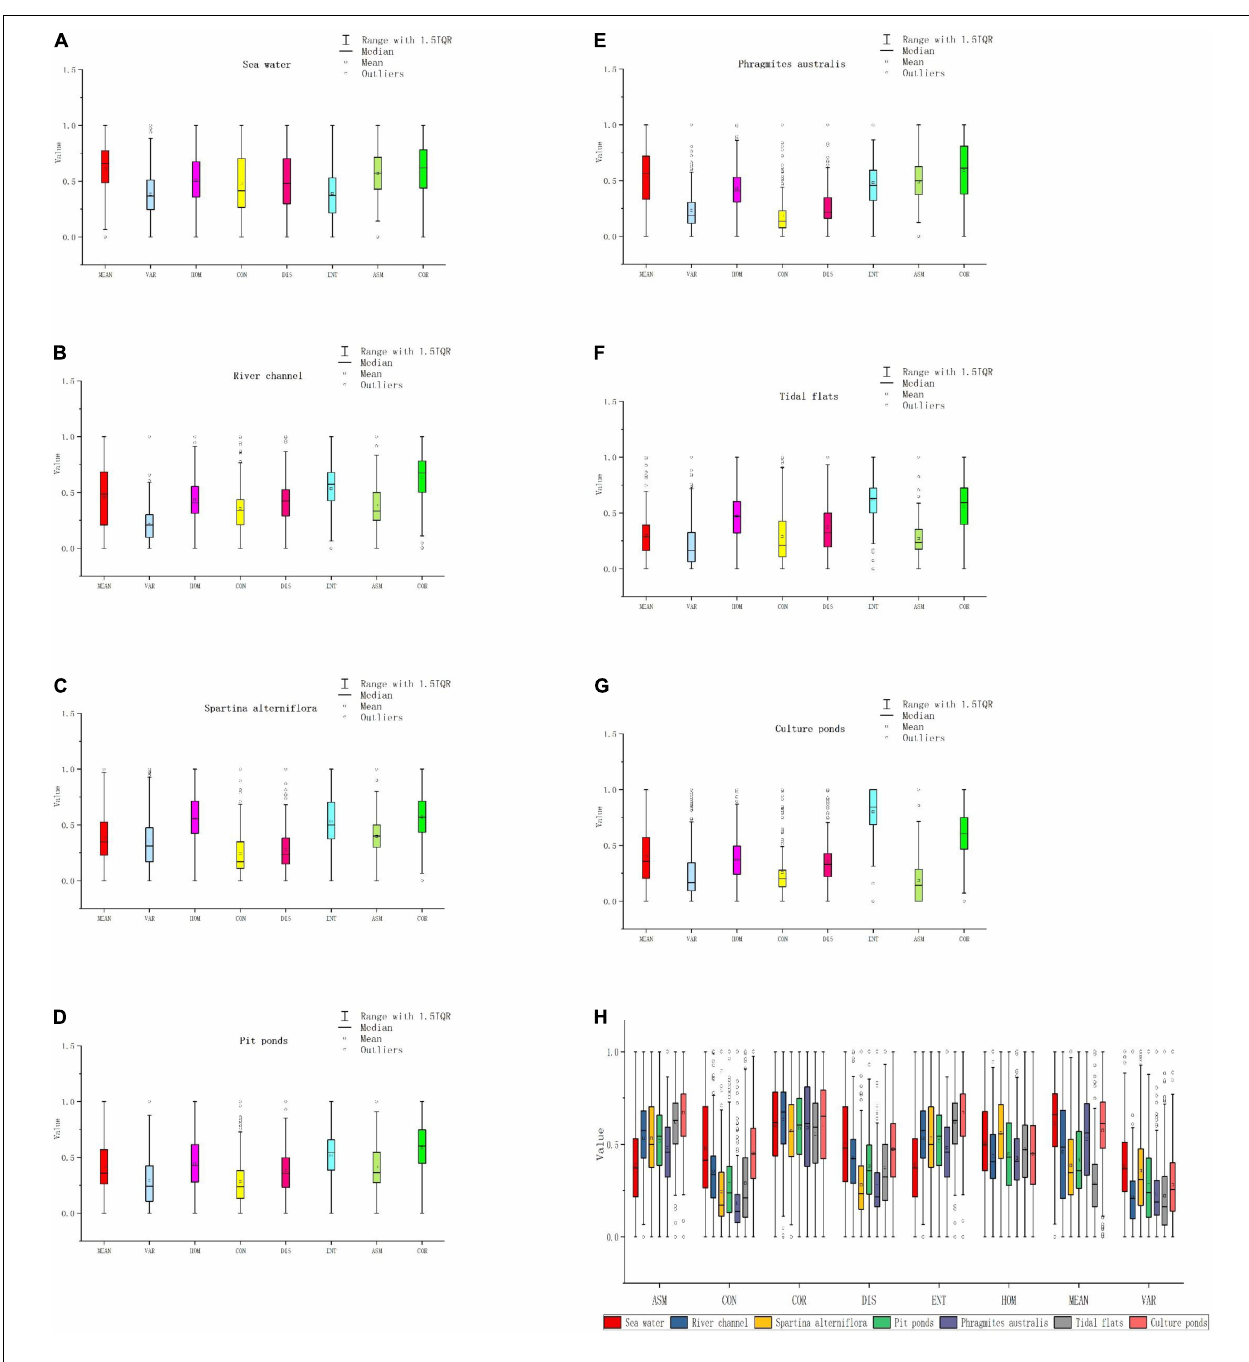
of producer accuracies, user accuracies, overall accuracies and Kappa coefficients were shown in Table 7